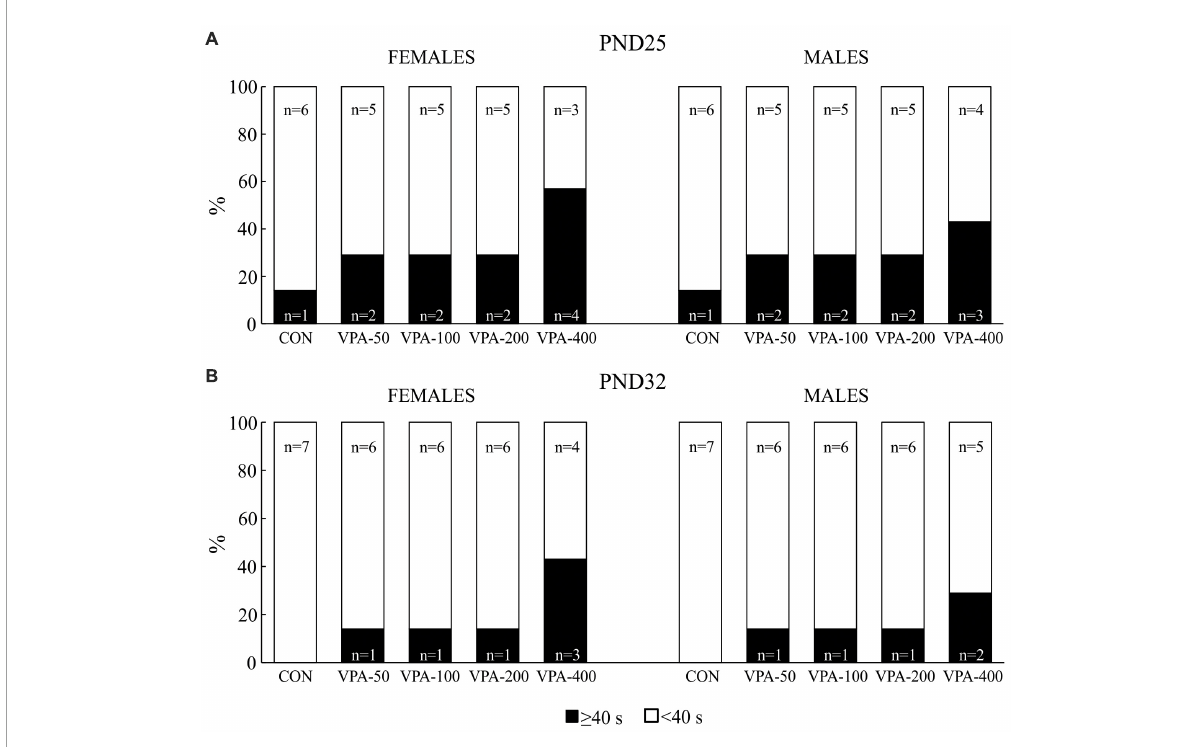
FIGURE2 Percentage of the total number of adolescent female and male mice prenatally exposed to VPA at doses of 50 mg/kg (VPA-50), 100 mg/kg (VPA-100), 200 mg/kg (VPA-200), and 400 mg/kg (VPA-400) that showed latencies less than 40 s ( < 40 s) and equal to or higher than 40 s ( ≥ 40 s) on PND25 (A) and PND32 (B) in the hot plate test. The control (CON) group was treated with